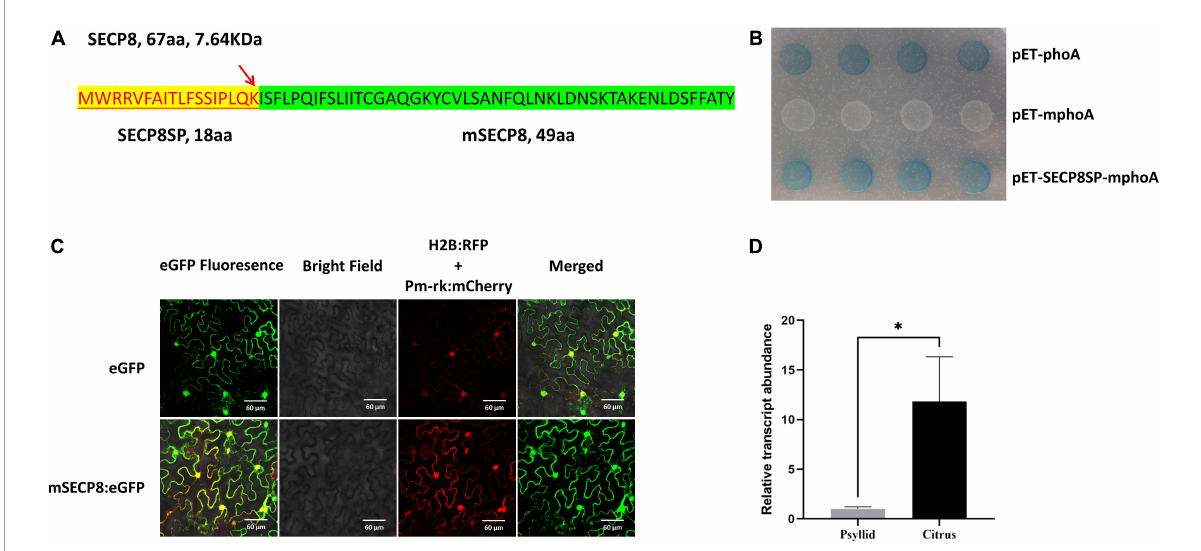
FIGURE1 In silico analysis and molecular biological characteristics of SECP8. (A) Analysis of SECP8 amino acid sequence. Amino acid sequence of SECP8 (67 aa, 7.64 KDa) with N-terminal signal peptide (SECP8SP, highlight in yellow), red arrow indicated the cleavage site between 18 and 19 amino acid positions (LQK-IS), SECP8 without the signal peptide SECP8SP was named mSECP8 (49 aa). (B) SECP8 encoded a Sec-delivered protein. PhoA assay was used for validating the secretion of SECP8 in Escherichia coli , E. coli cells harboring the SECP8SP-mPhoA fusion protein turned blue which were similar to PhoA protein (positive control), while negative control mPhoA (without the SP) protein exhibited white on indicator LB medium. It was photographed after 12 h incubation at 37 ◦ C. (C) mSECP8 was localized in multiple subcellular compartments of Nicotiana benthamiana . Subcellular localization of mSECP8:eGFP fusion protein was observed via confocal microscopy with the following parameters: eGFP, 488 nm laser wavelength and 510 nm emission wavelength; H2B and Pm-rk, 561 nm laser and 583 nm emission filters. A histone 2B (H2B) fusion with the red fluorescent protein (RFP) and pm-rk CD3-1007 (mcherry) were used as nuclear and plasma membrane location marker, respectively. The samples were collected at 2 dpi. Scale bars represent 60 µ m. (D) Relative expression of SECP8 in citrus and psyllids. Transcript abundance of SECP8 was normalized against its expression in C las-infected Wanjincheng orange and psyllids by RT-qPCR. Bars represented the standard error (SE) of the means, CLasgyrA ( CLIBASIA_00325 ) was used as an internal reference. The asterisks indicate significant difference ( ∗ p < 0.05, determined by Student’s t -test). The experiment comprised at least three independent biological replicates and three technical